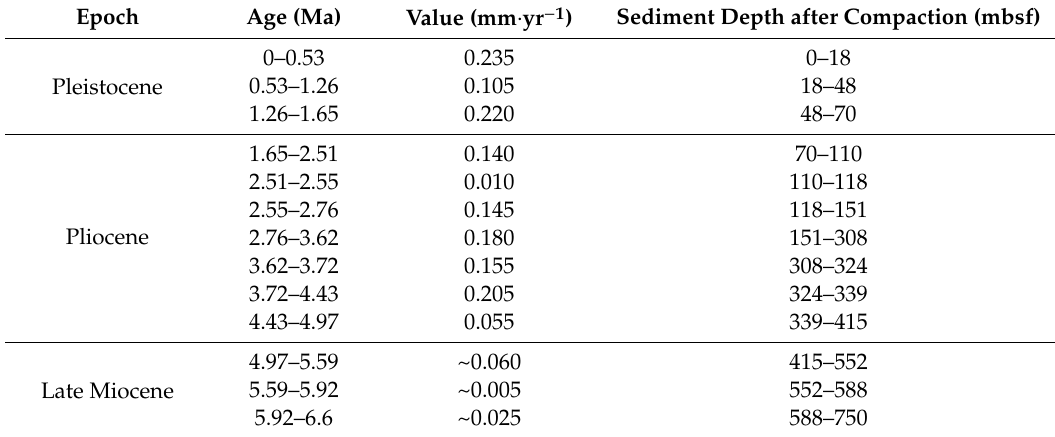
Table 2. Rates of sediment accumulation at Blake Ridge Site 997 after Ikeda et al. [37]. Epoch Age (Ma) Value (mm · yr − 1 ) Sediment Depth after Compaction